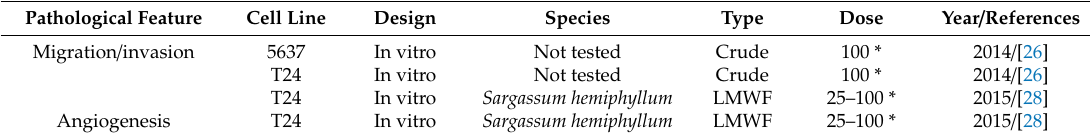
Table 2. Fucoidan-induced changes of cell survival-related molecules.